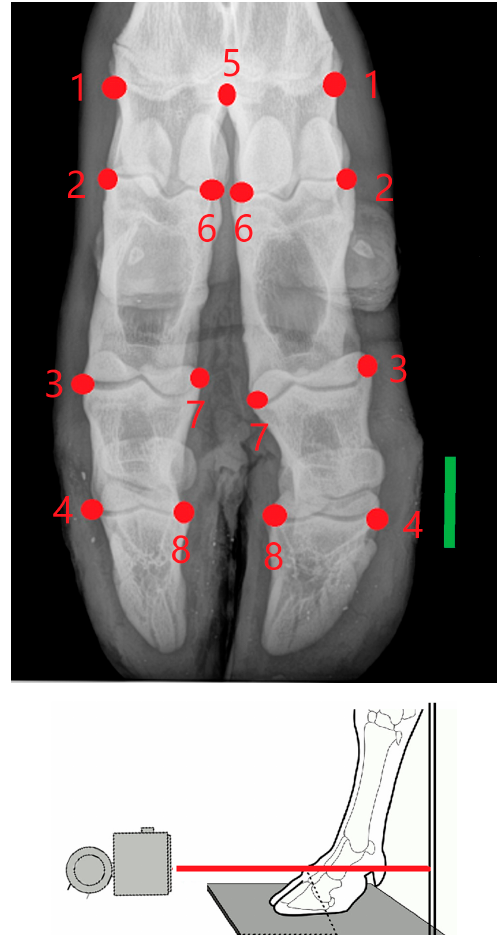
Figure 1. Dorso ‐ palmar view of acropodium on which seven landmarks occurring on both sides of the acropodium joints (no. 2 to 4, and 6 to 8), abaxial metacarpal distal joint (no. 1) and one axial (no. 5, on the distal metacarpal epiphysis) were located. The bar is 3 ‐ cm long. For each limb, the X ‐ ray beam in the images passed through the proximal interphalangeal joint.